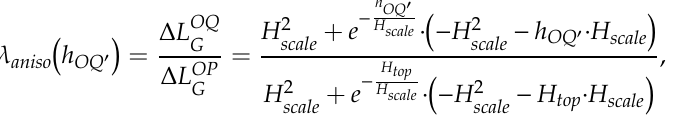
Figure 5. The anisotropic height factor changes with height.